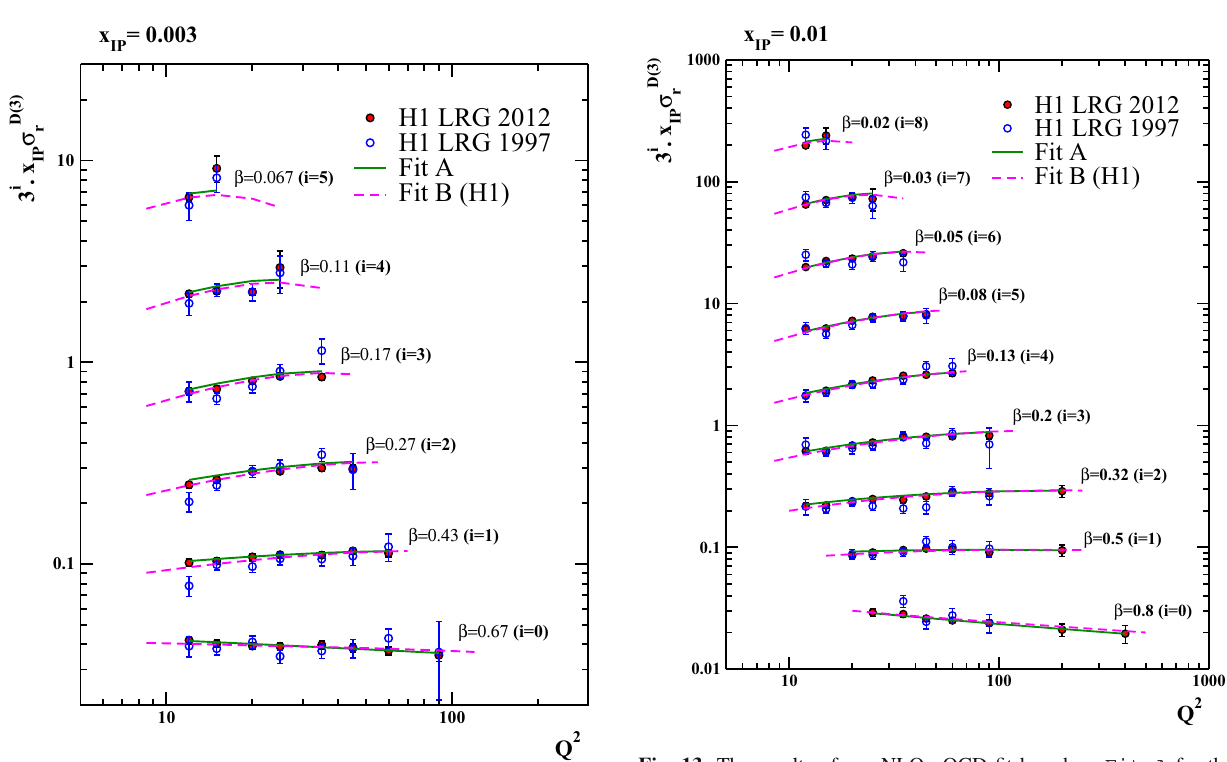
Fig. 13 The results of our NLO pQCD fit based on Fit A for the ( 3 ) 2 for dif- reduced diffractive cross section x IP σ D Fig. 12 The results of our NLO pQCD fit based on Fit A for the r as a function of Q ( 3 ) ferent values of β and x IP = 0 . 01. The data are correspond to the H1 2 for dif- reduced diffractive cross section x IP σ D r as a function of Q LRG 2012 [44] and H1-LRG-1997 [27] measurements. See the caption ferent values of β and x IP = 0 . 003. The data are correspond to the of Fig. 12 for further H1-LRG-2012 [44] and H1-LRG-1997 [27] measurements. The data are multiplied by a further factor of 3 i for visibility, with i as indicated